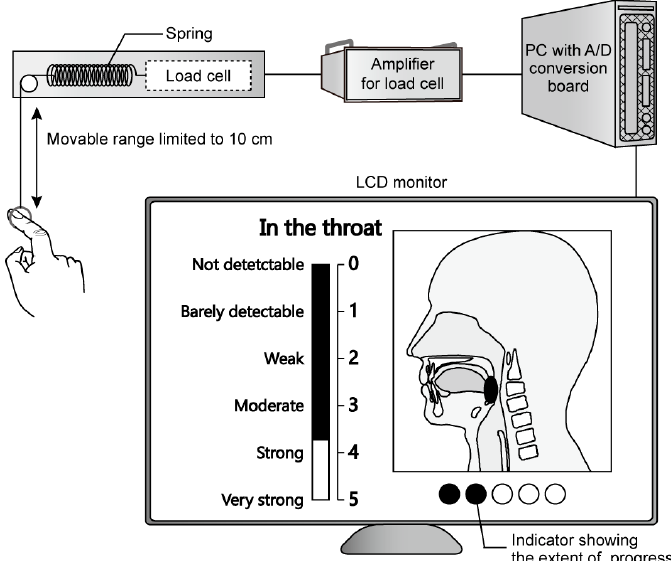
Figure 1. Outline of the TI evaluation system. PC: personal computer; A/D: analog-to-digital; LCD: liquid crystal display.